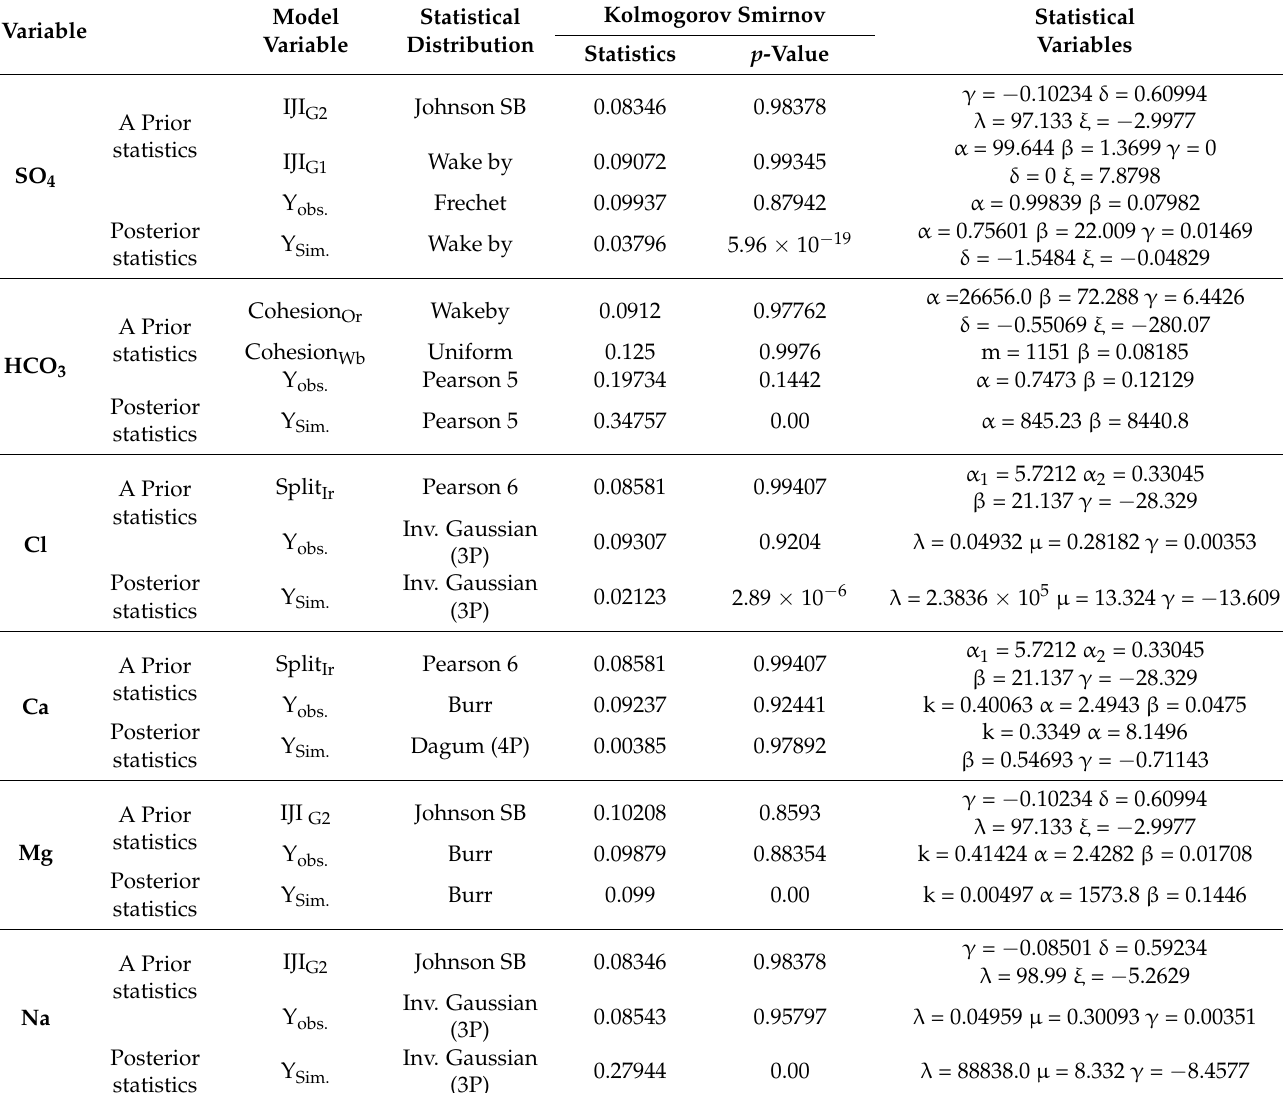
Table 7. Results of optimal statistical distribution for the variables of the regression